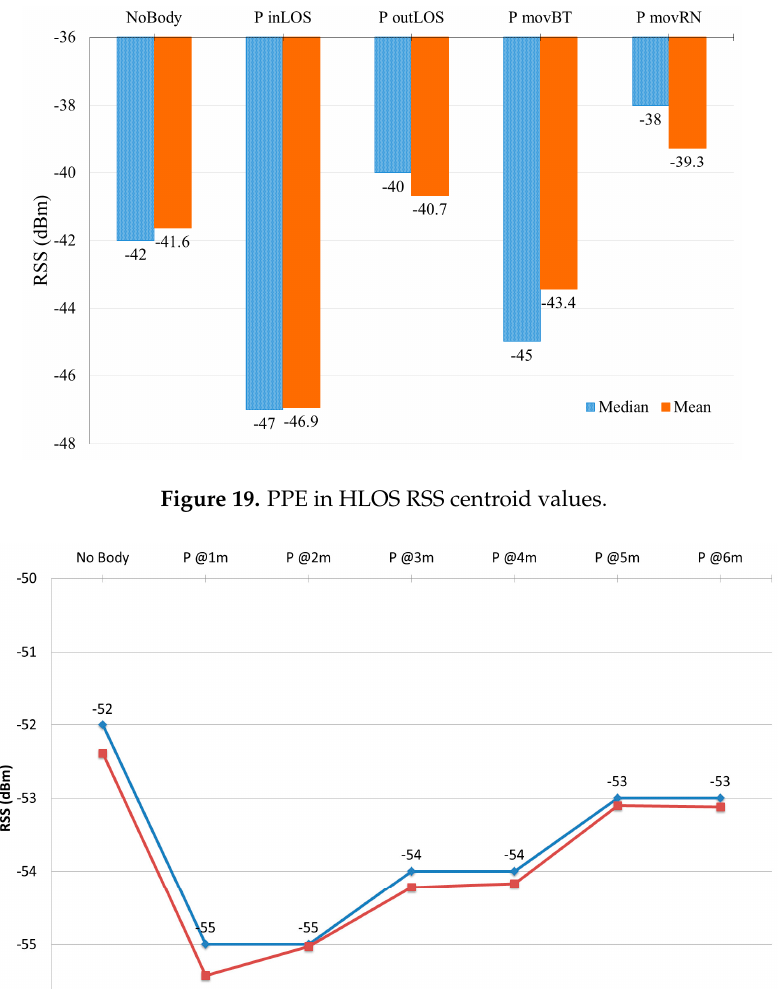
Figure 20. PPE in DLOS.